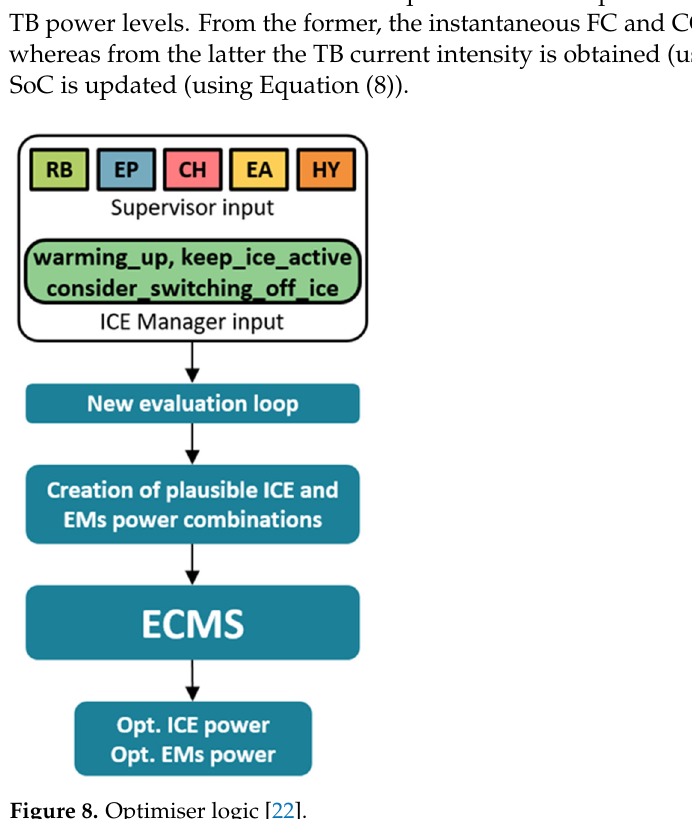
Figure 8. Optimiser logic